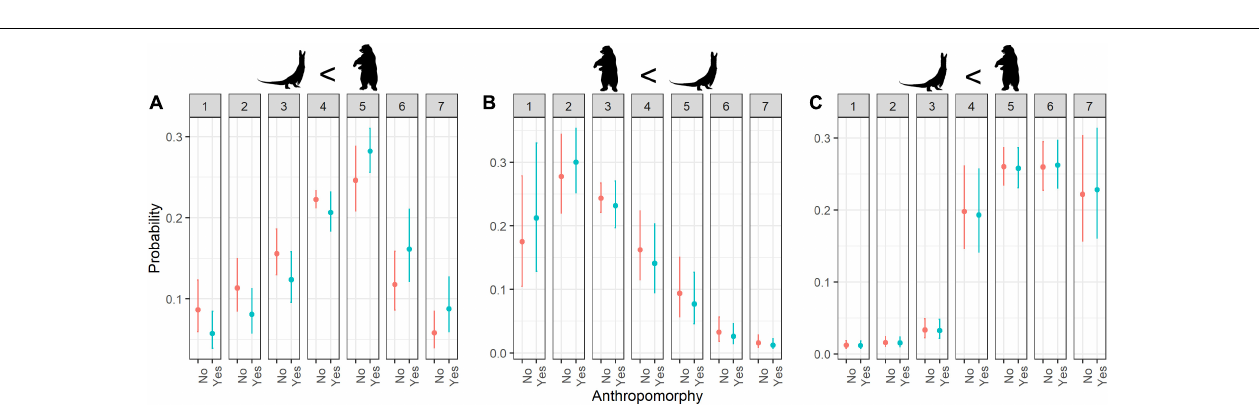
FIGURE 3 | Estimated probability of ratings for cuteness, fear and willingness to protection according to Phylogeny (A) , interaction effects of Phylogeny:Size for Cuteness (B) . Error areas indicate 95% confidence interval; numbers 1–7 refer to rating scores.